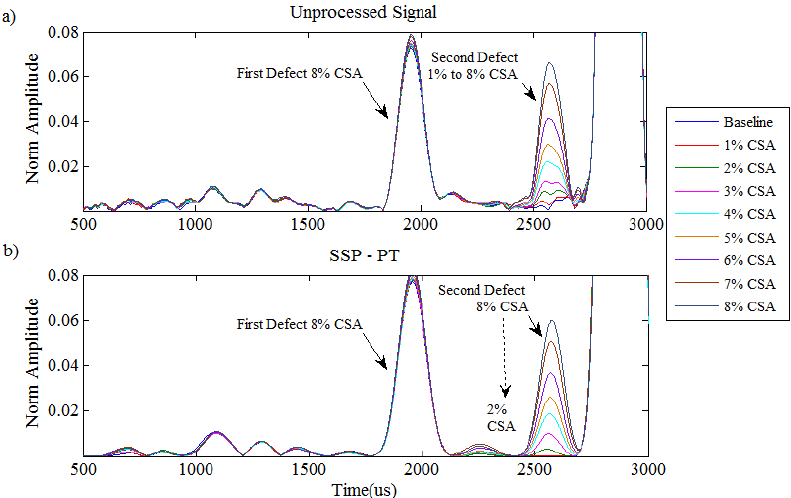
Figure 11. Zoom in result with two defects. ( a ) Unprocessed signal; ( b ) SSP signal.